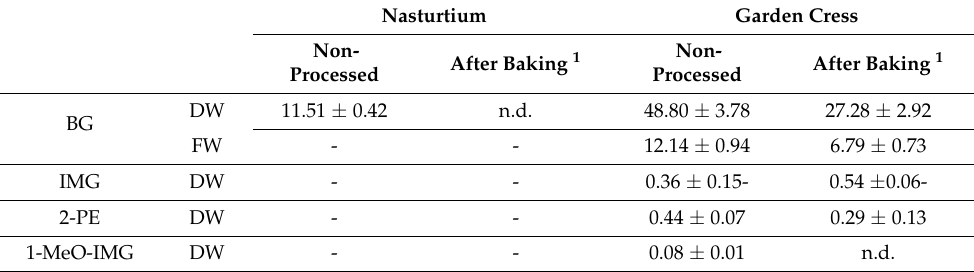
Table 2. GLS profiles and contents in nasturtium ( Tropaeolum majus L.) and garden cress (